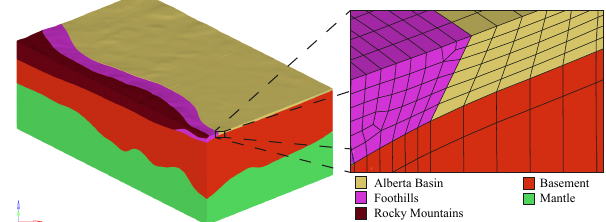
Figure 8. 3-D view of the Alberta model, view from south to north – rock units are indicated by colours. A small cut-out is zoomed in to see the mesh in detail. The vertical exaggeration is 5